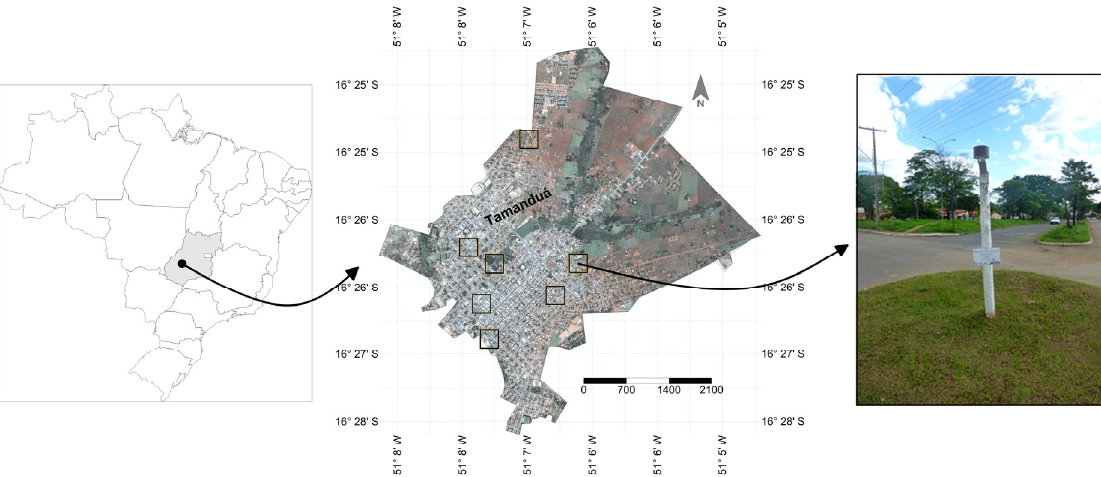
Figure 1. Location of the city of Iporá and the measurement sites.